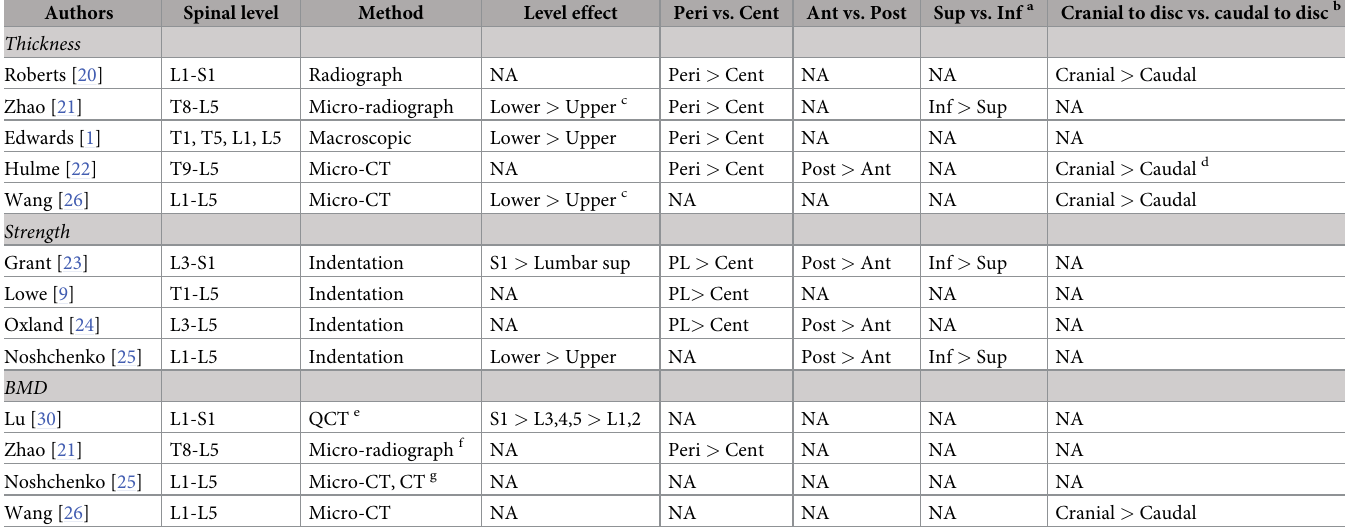
Table 3. Studies on lumbar endplate thickness, strength and bone mineral density (BMD).